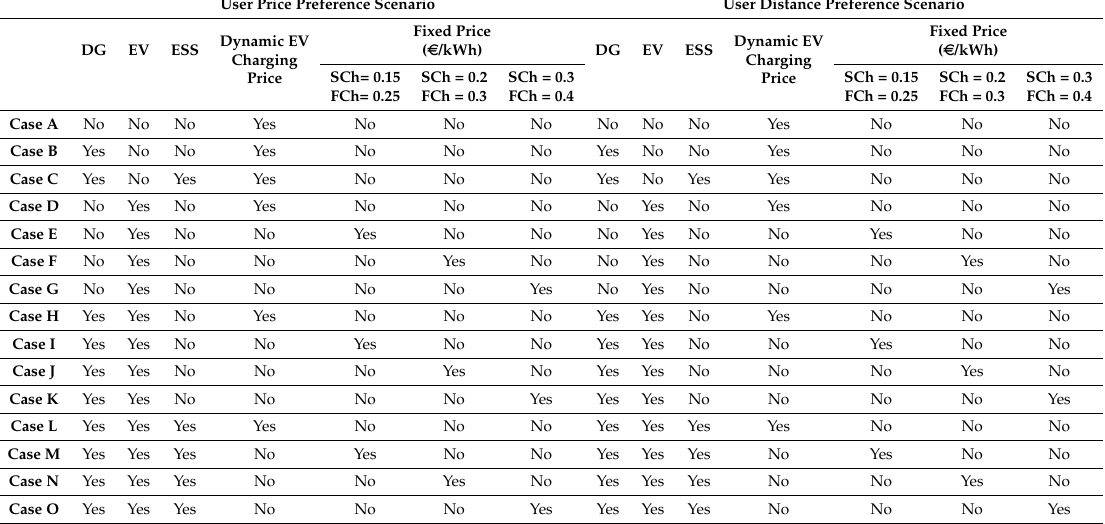
Table 8. Case study